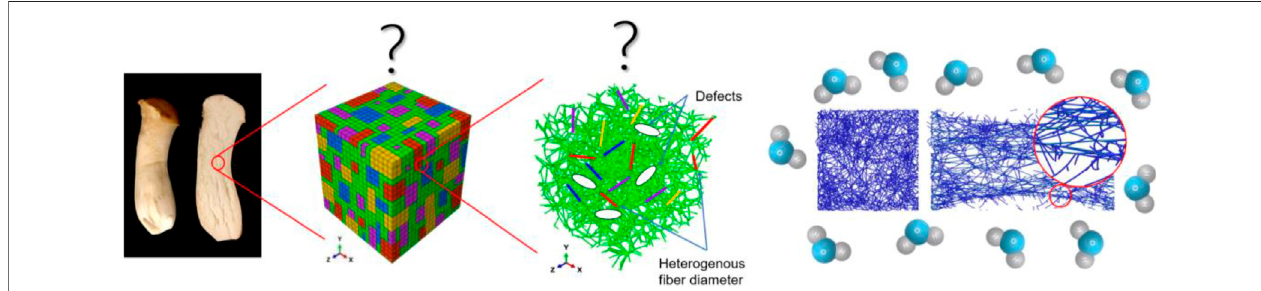
FIGURE 8 | Multiscale model of mycelium network and its composite from the fi nite element model (Islam et al., 2017) (reproduced under a creative commons attribution license) to fi brous networks and its interface with water and other materials in the substrates.